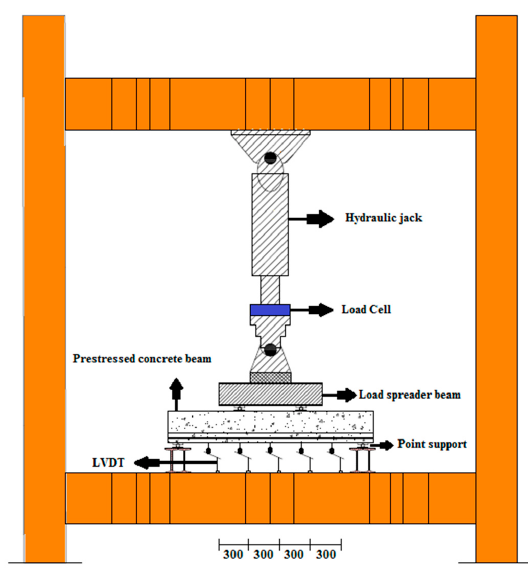
Figure 9. Schematic of the four-point flexural test setup.